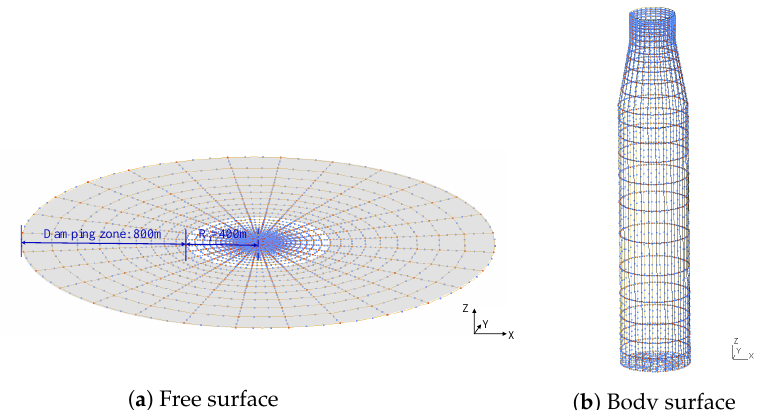
Figure 13. Example of mesh models on the free surface and the substructure of the 6 MW spar-type